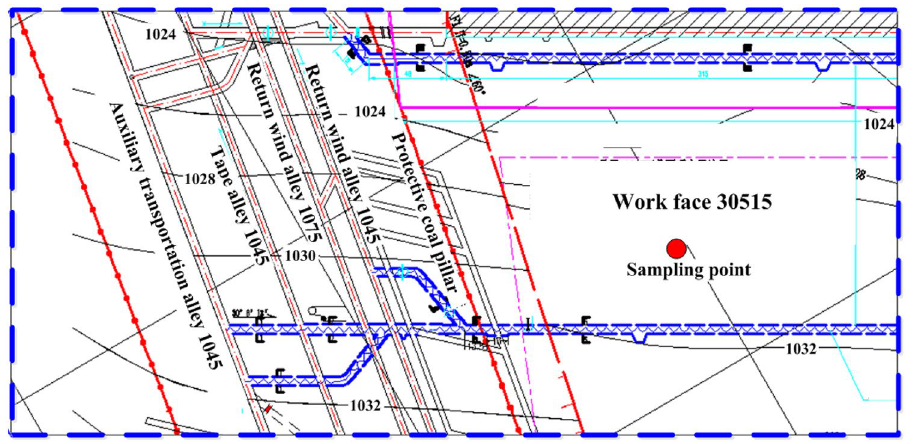
Figure 1. The location of the longwalls where the coal samples were